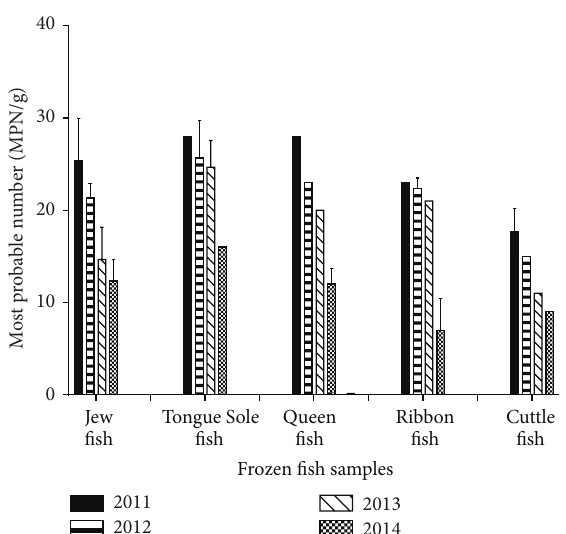
Figure 2: Total coliforms count (MPN/g) of frozen fish samples. The data were representatives of the three independent experiments using triplicate samples and mean ± SD values were expressed.